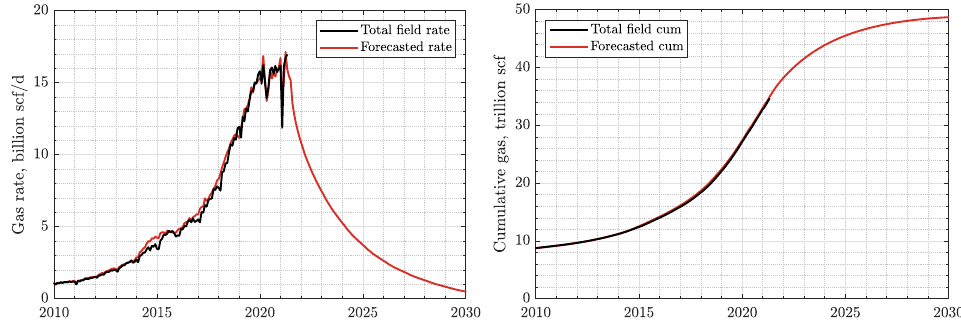
Figure 10. Base case forecast of natural gas production from 53,708 existing horizontal wells com- pleted in the Permian tight reservoirs. The estimated ultimate recovery is about 48.5 trillion scf of